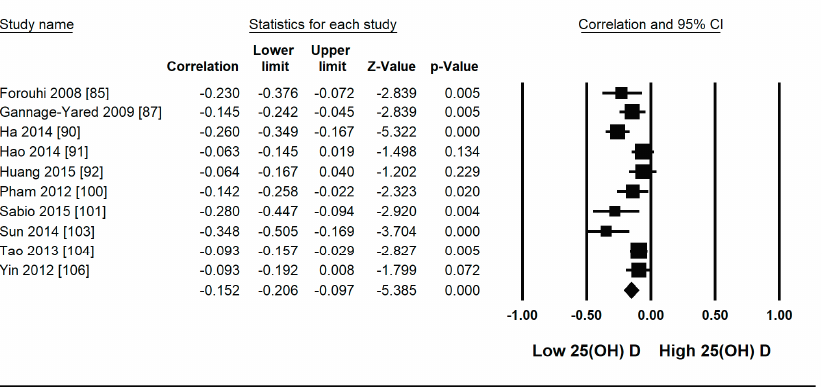
Figure 7. Forest plot for the lowest BMI quartile (<25) of non-diabetic subject studies showing the correlation between the status of vitamin D and fasting plasma insulin. The random effects model was used for the determination of correlation and 95% CI [85,87,90–92,100,101,103,104,106].